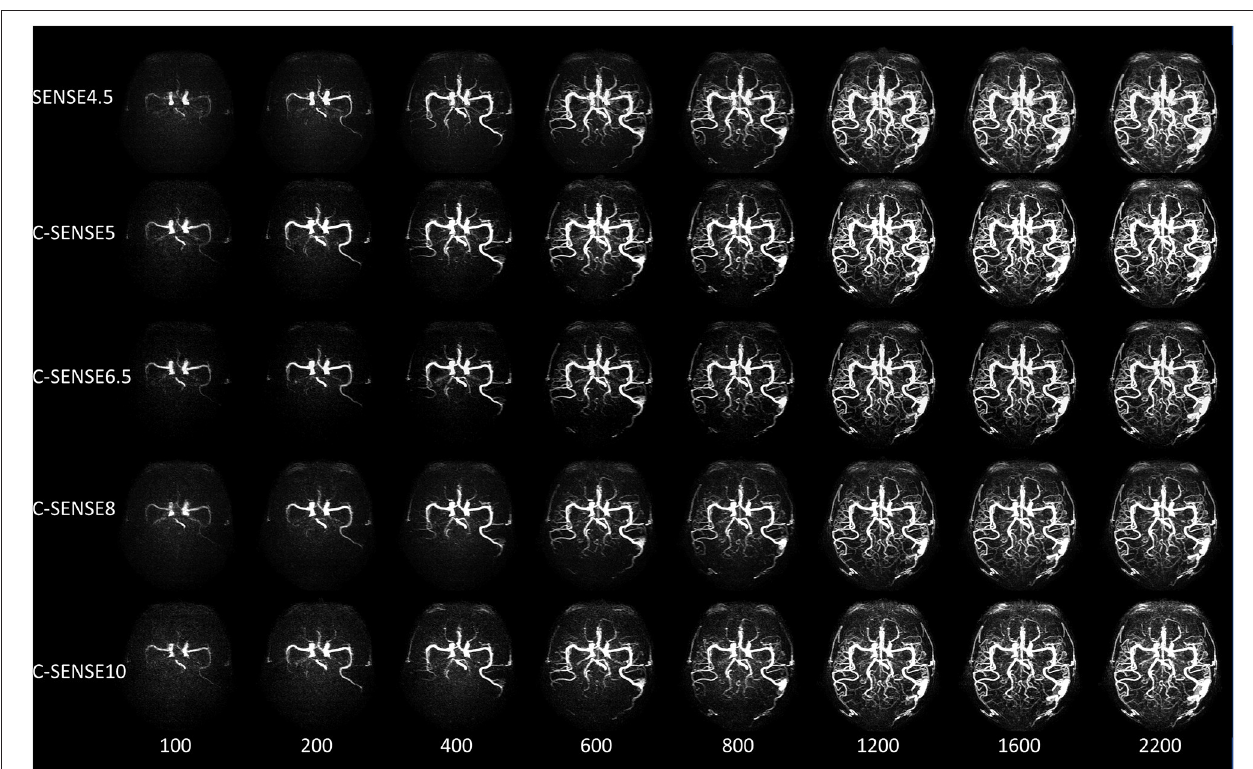
FIGURE 4 | A 50-year-old woman with arterial venous malformation. The feeding artery, the nidus, and the draining vein were clearly visible from 600 to 2,200ms in all sequences, while the distal vessels of the middle cerebral artery had vague margins in images acquired by C-SENSE8 and C-SENSE10 vs. SENSE4.5, C-SENSE5, and C-SENSE6.5